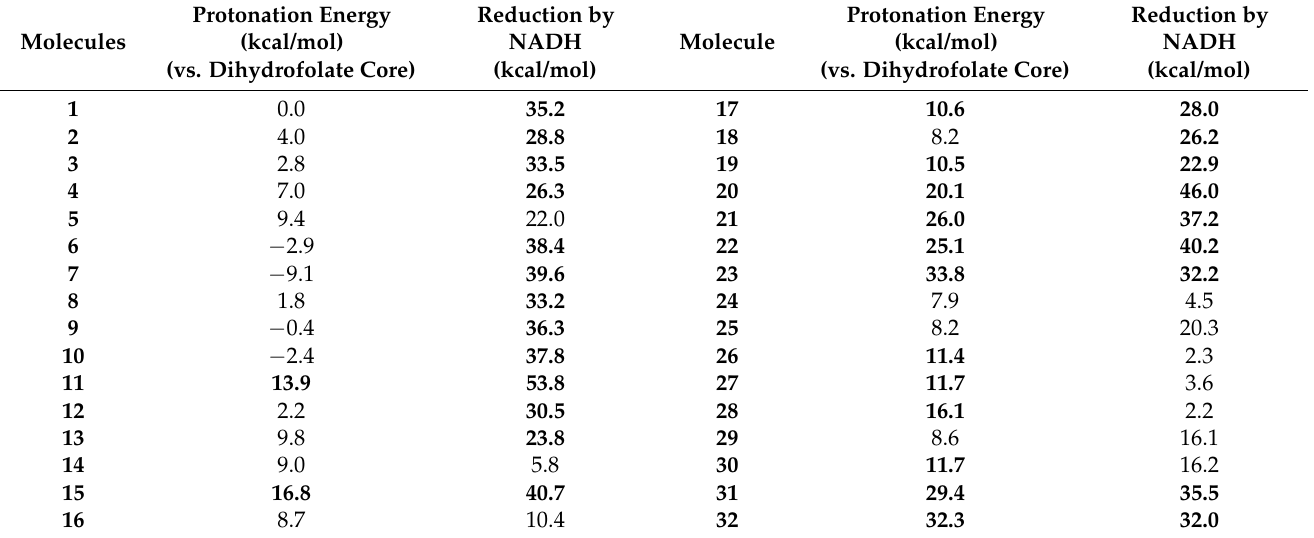
Table 1. PBE0/6-311+G(2d,p)//PBE0/6-31+G(d) energies for the protonation (at position 5) and hydride transfer from NADH to each molecule (in its original protonation state). Bolded values show molecules significantly less basic than the pteridine core (>10 kcal · mol − 1 difference) or with reduction energies above 22 kcal · mol − 1 .